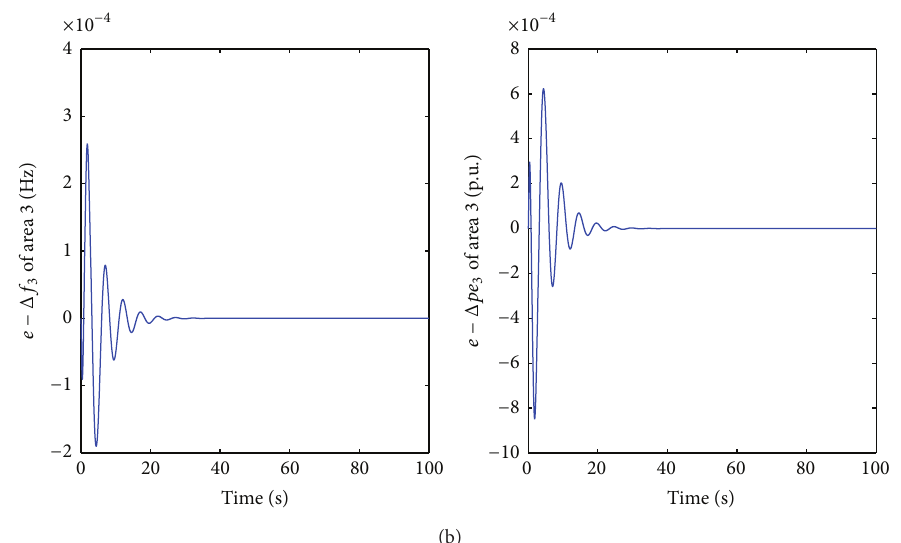
Figure 11: Step load disturbance responses and observation errors of the expanded system when two original-construction subsystems are designed by LQG